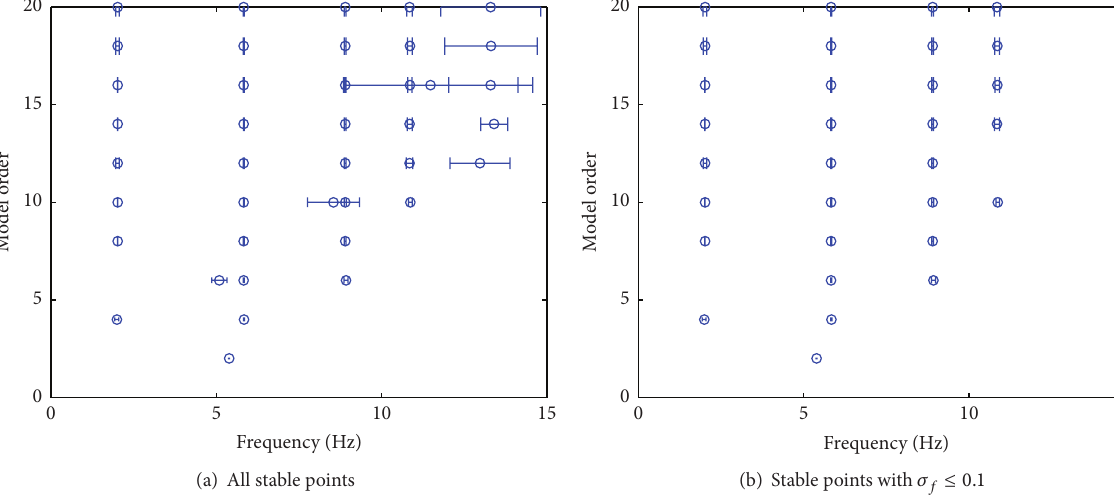
Figure 4: Stabilization diagram with confidence intervals of the frame structure.